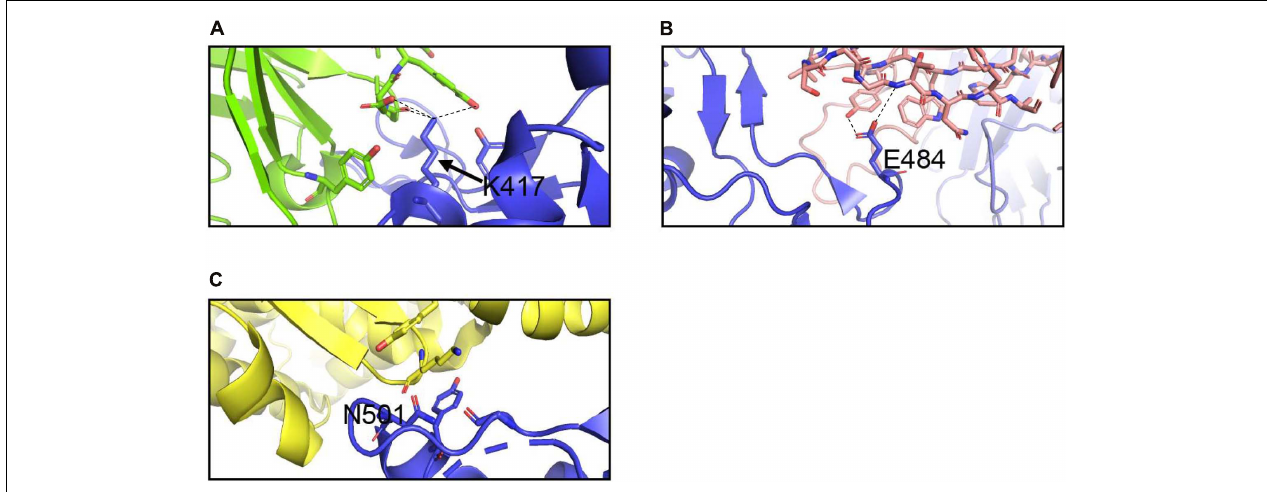
FIGURE 6 | Interactions of K417, E484, and N501 of the S protein with neutralizing antibodies and hACE2. (A) Interaction of K417 (blue) with C102 Nab (green) residues. (B) Interaction of E484 (blue) with C121 Nab (light pink). (C) Interaction of N501 (blue) with hACE2 (yellow) Dashes lines indicate interactions between residues. The graphs were generated using